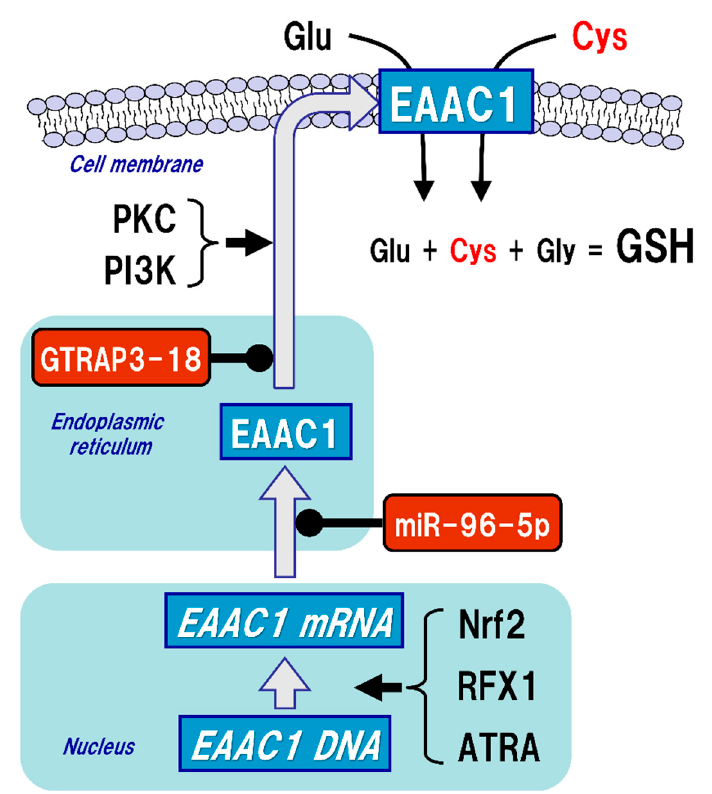
Figure 3. Regulation of excitatory amino acid carrier 1 (EAAC1) expression. Glutathione (GSH) is a tripeptide synthesized from glutamate (Glu), cysteine (Cys), and glycine (Gly). Neuronal GSH synthesis relies on intracellular Cys but not Glu or Gly level. Cys uptake (red font) is subjected to the regulation of both gene expression and post-translational modifications of EAAC1 under facilitative (arrow) and suppressive (black circles) controls. EAAC1 gene expressions are promoted by nuclear factor erythroid 2-related factor 2 (Nrf2), regulatory factor X1 (RFX1), and all-trans-retinoic acid (ATRA). Protein kinase C (PKC) and phosphoinositide 3-kinase (PI3K) activations increase the EAAC1 expression on the plasma membrane. Glu transporter-associated protein 3-18 (GTRAP3-18) and miR-96-5p post-translationally suppress the protein expression of EAAC1, leading to decreased Cys uptake and subsequently decreased GSH synthesis in neurons.